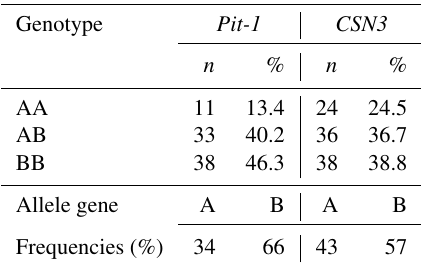
Figure 4. PCR-RFLP gel image of CSN3 / Hinf I polymorphism. AA: 131/89bp, AB: 262/131/89bp, BB: 262/89bp. Table 4. Pit-1 and CSN3 genes, genotype, and allele gene frequen- cies of calves.